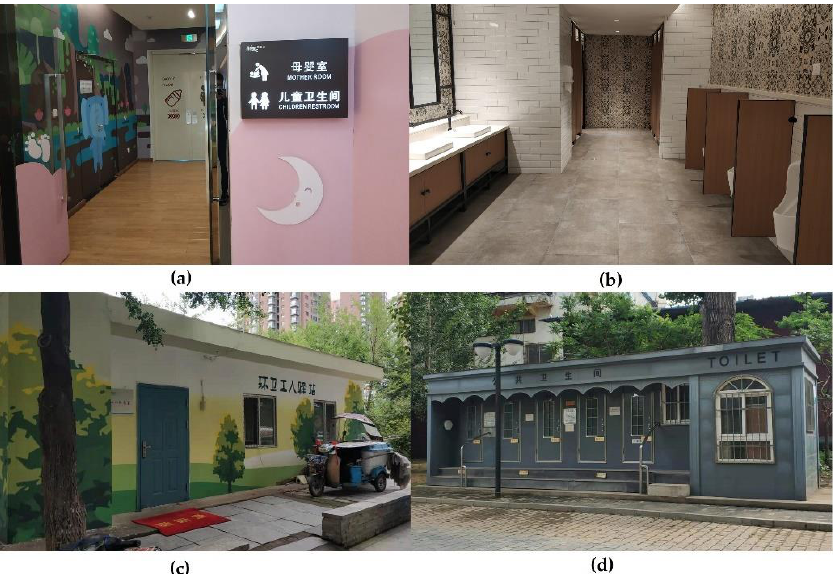
Figure 10. Field photos of public toilets: ( a ) Mother room and children restroom; ( b ) the interior of the dependent public toilets; ( c ) the station for sanitation workers; ( d ) the independent public toilets.